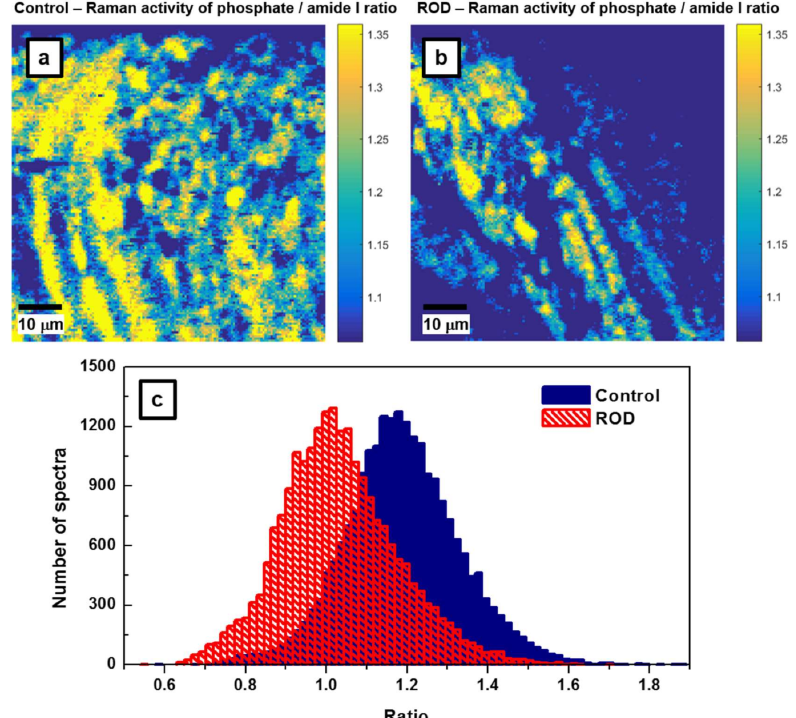
Figure 4. ( a , b ) Raman mapping images for the control and ROD bone samples of phosphate/amide I ratios, which correspond to activities of the bands centered around 960 cm − 1 and 1660 cm − 1 , respectively. This ratio is associated with the mineral-to-matrix content in the samples. ( c ) Statistical analysis associated with Raman mapping images in Figure